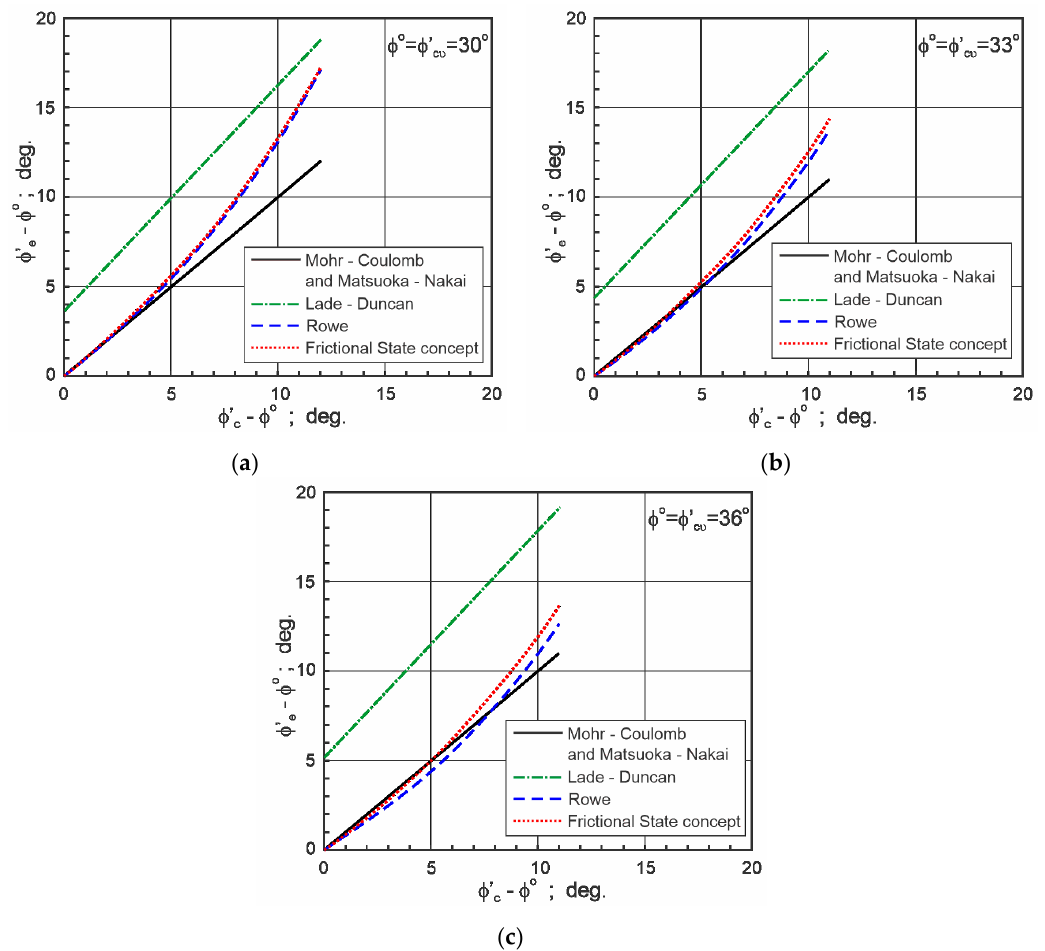
Figure 3. Relationship between excesses of friction angles for triaxial extension and triaxial φ ◦ = φ (cid:48) = 30 ◦ , ( b ) φ ◦ = φ (cid:48) compression: ( a ) ( a ) c υ